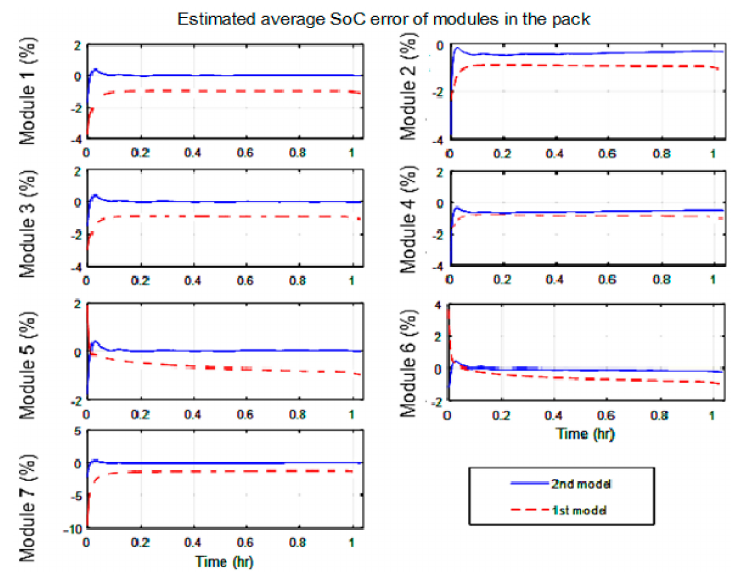
Figure 14. The SoC estimation error comparison between the two cases : using the first order dynamic model and the second order dynamic model of the cell at 25 ◦ C.